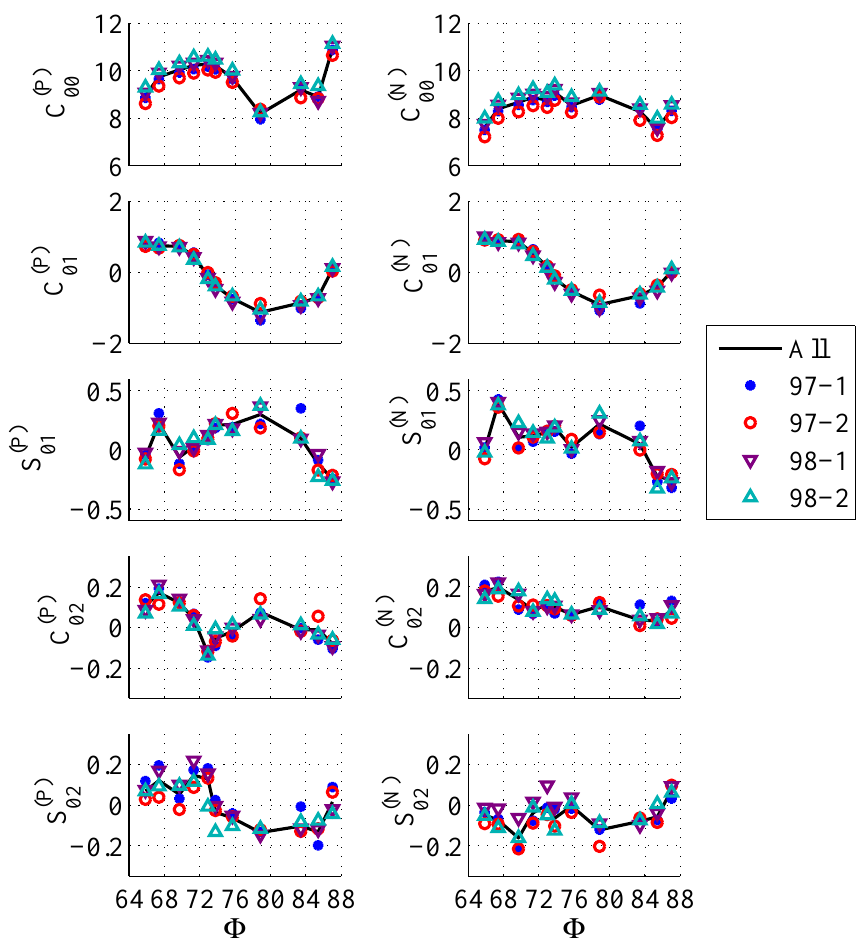
Fig. 4. Coefficients of the Fourier expansion (6) of σ . The P and N components are given in the left and right panels, respectively. The results for the whole two-year observational interval are shown by a solid line, and the results for half-year intervals are shown by markers. The years are given in first two numbers on the legend, and the third number corresponds to half-year intervals: 1 is January–June, and 2 is